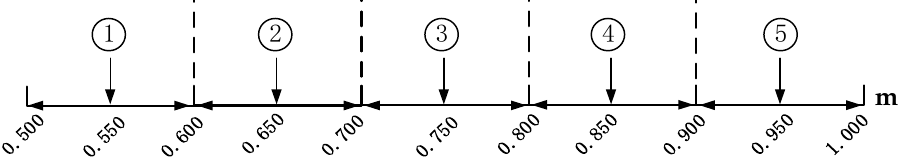
Figure 11. The starting point diagram of the specific modulation index.